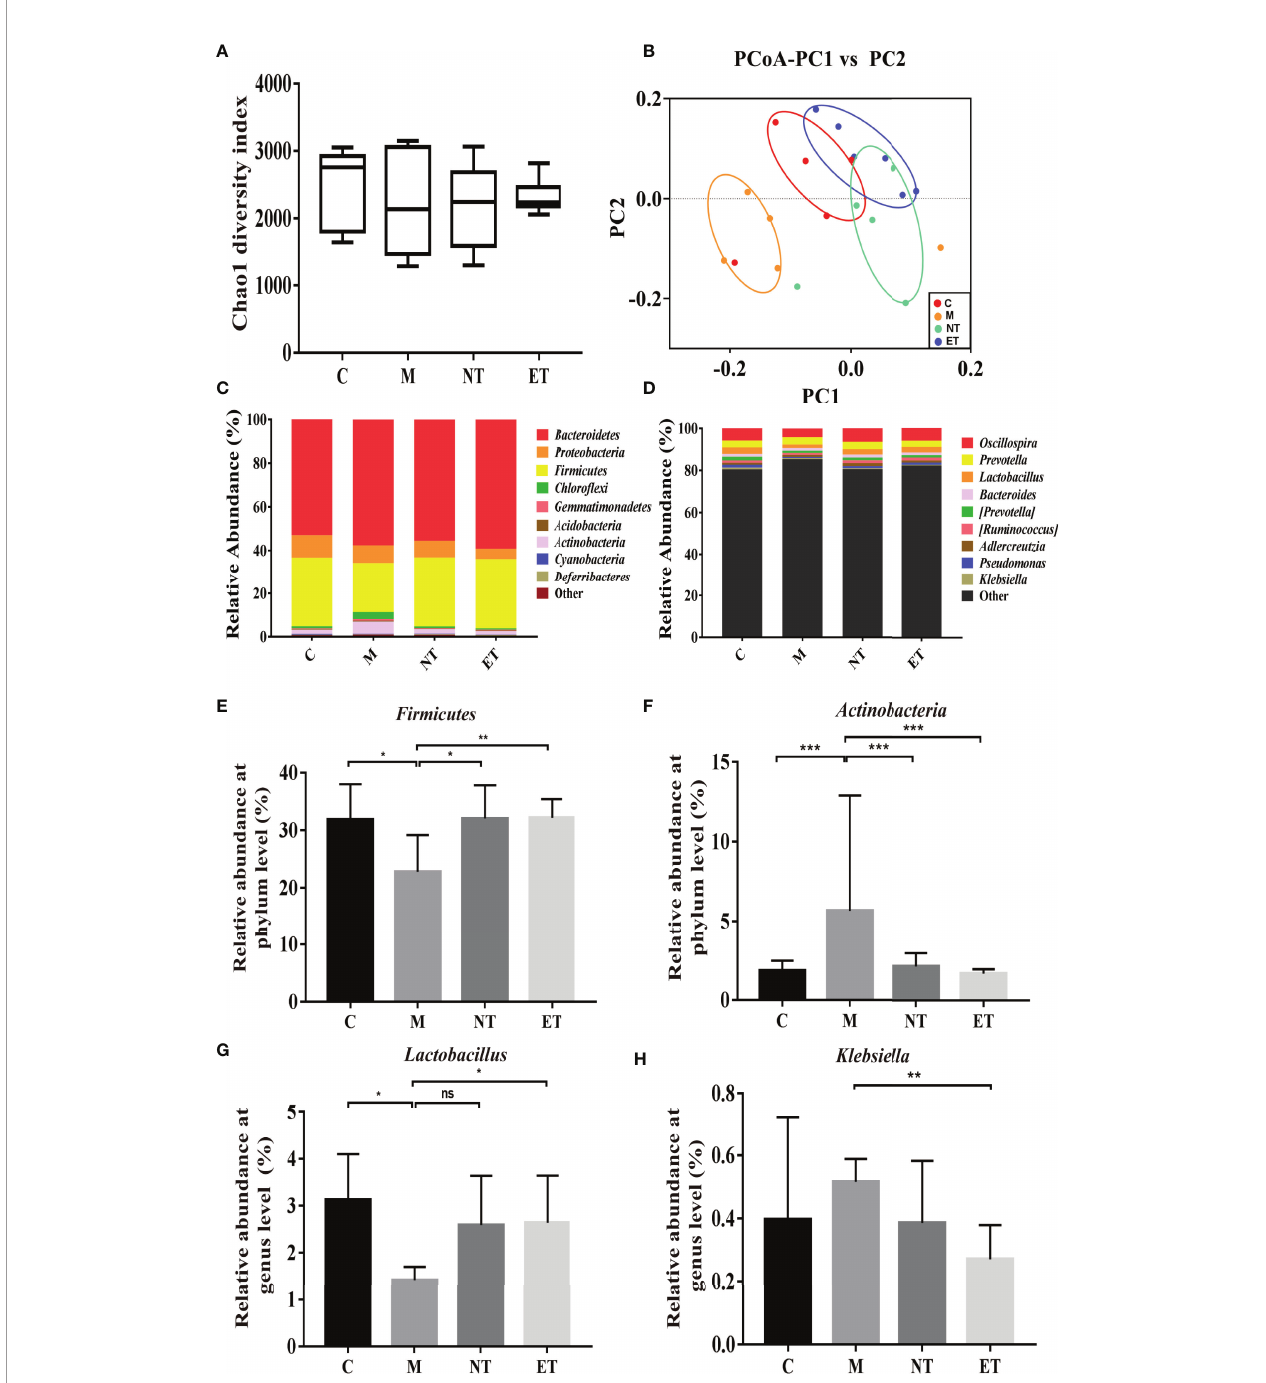
FIGURE 3 | Effects of L. crispatus -pMG36e-mCXCL12 on vaginal microbiota in intrauterine adhesion mice. Evaluation of the effect of L. crispatus -pMG36e- mCXCL12 on vaginal microbiota of intrauterine adhesion mice using (A) the Chao1 Diversity, (B) the PCoA of the b diversity index, the relative abundance (C) at the phylum level and (D) at the genus level. Evaluation of the effect of L. crispatus -pMG36e-mCXCL12 on the relative abundances of the phyla (E) Firmicutes , (F) Actinobacteria in intrauterine adhesion mice; Evaluation of the effect of L. crispatus -pMG36e-mCXCL12 on the relative abundances of the genera (G) Lactobacillus , (H) Klebsiella in intrauterine adhesion mice. C group, Control group; M group, laparotomy was used to construct a model of intrauterine adhesion; NT group was treated with L. crispatus for intrauterine adhesion mice; ET group was treated with L. crispatus -pMG36e-mCXCL12 for intrauterine adhesion mice. Unpaired t-test was used for statistical analysis and all data are presented as mean ± standard deviation (SD). ns, P > 0.05; *P < 0.05; **P < 0.01; ***P <